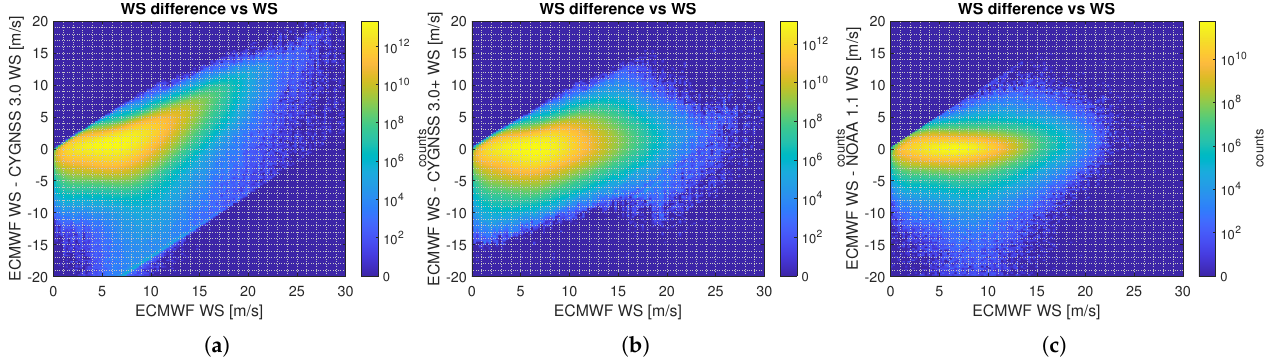
Figure 5. Histograms of the difference between different CYGNSS wind estimates and ECMWF winds vs the same ECMWF winds: ( a ) CYGNSS SOC FDS MV 3.0, ( b ) CYGNSS SOC FDS MV 3.0 with SWH correction, and ( c ) OSWT